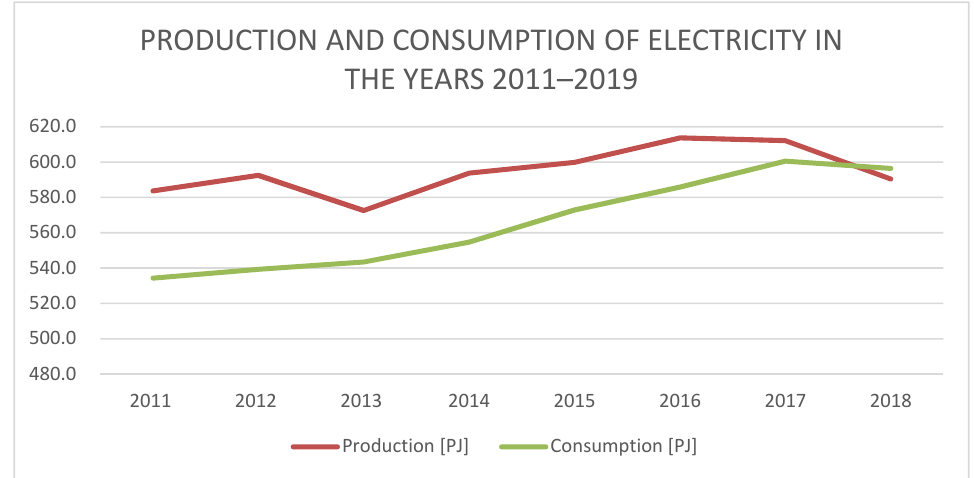
Figure 4. Production and consumption of electricity in Poland: 2011–2019. Source: G ł ówny Urz ą d Statystyczny.